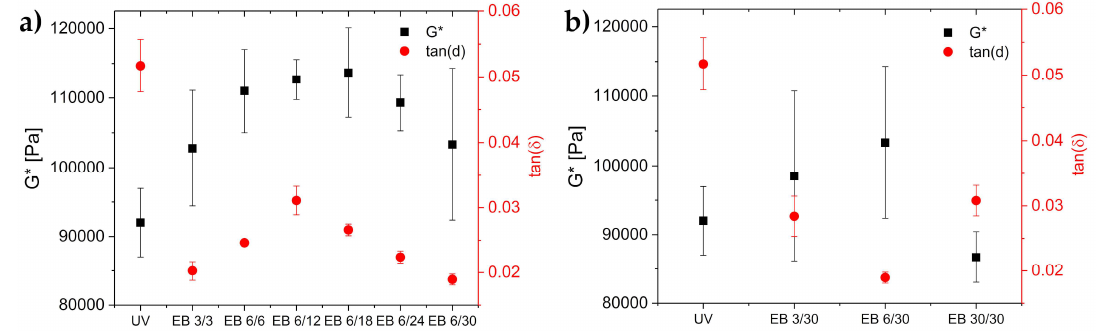
Figure 3. Dynamic modulus (G*) and loss factor (tan( δ )) of the UV-cured hydrogels compared to the hydrogels cured with electron beam, with the variation of ( a ) the total doses and ( b ) the differential doses. All data were recorded at 1 Hz.